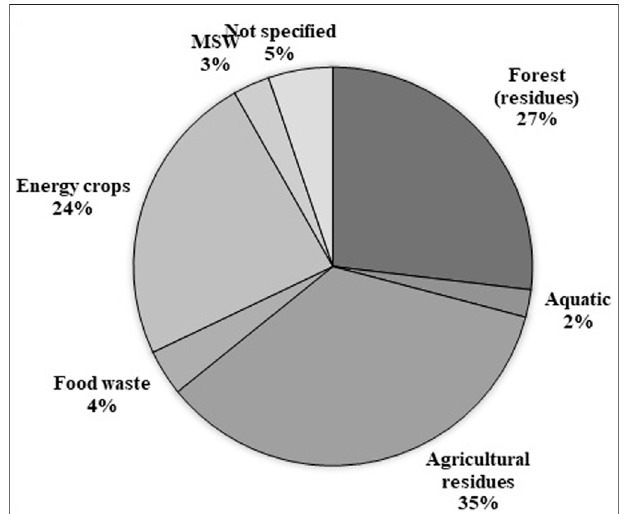
FIGURE 6 | Objectives used in the studies.